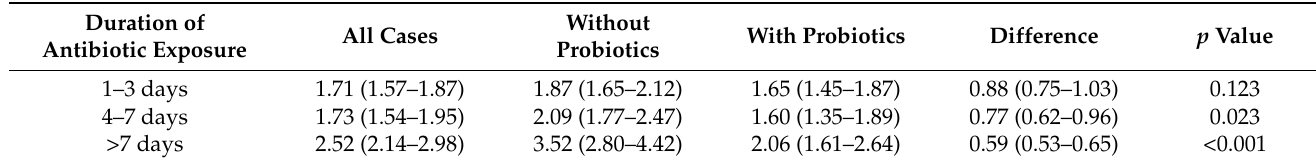
Table 2. Crude association between antibiotic exposure and hospitalisation, with and without probiotics, and their differences in multiplicative scale. Duration of Antibiotic Exposure